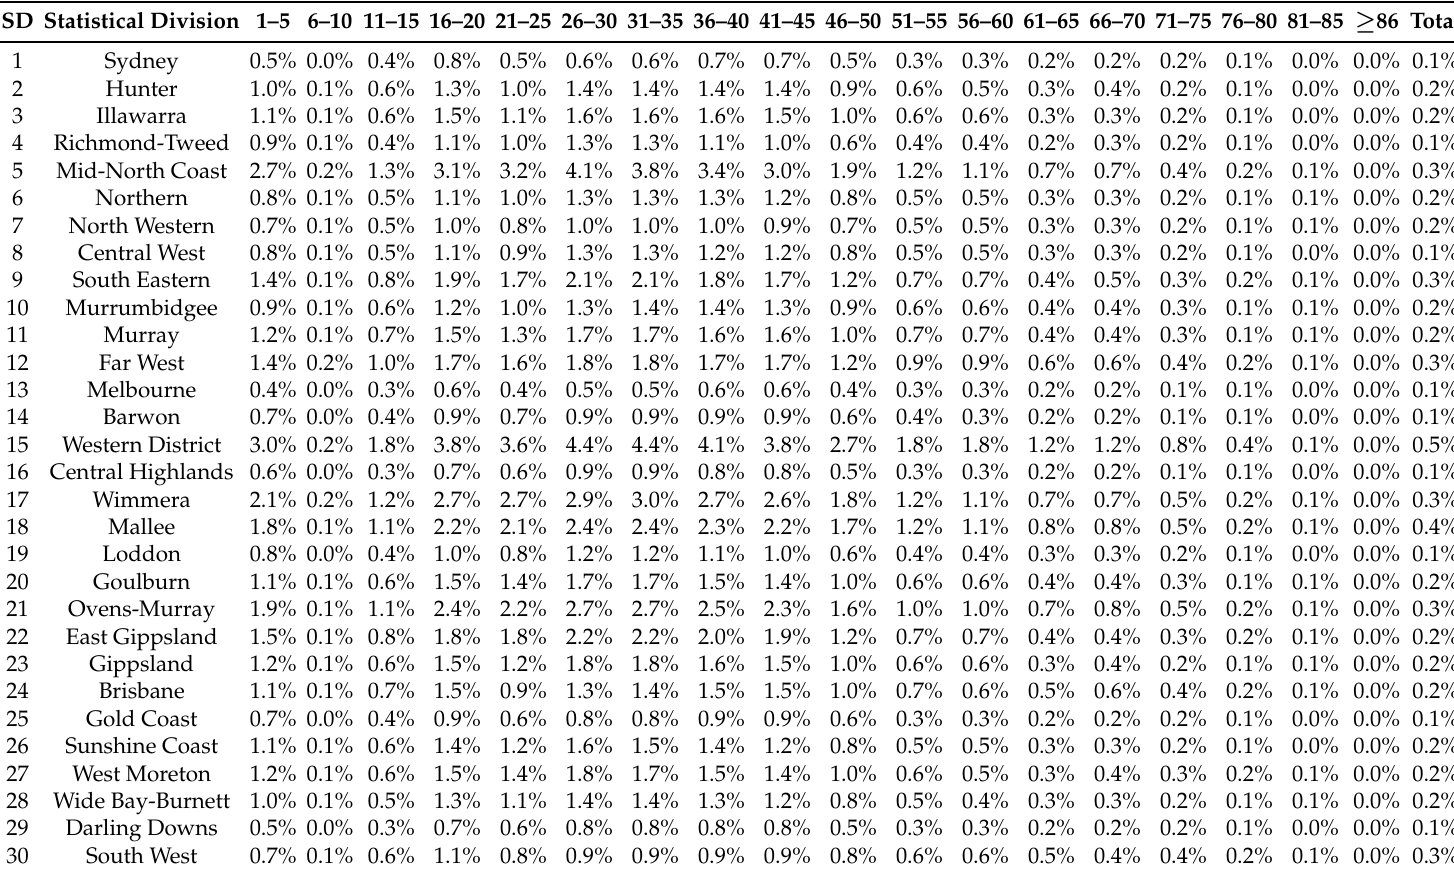
Table A4. Proximity Effects per 10